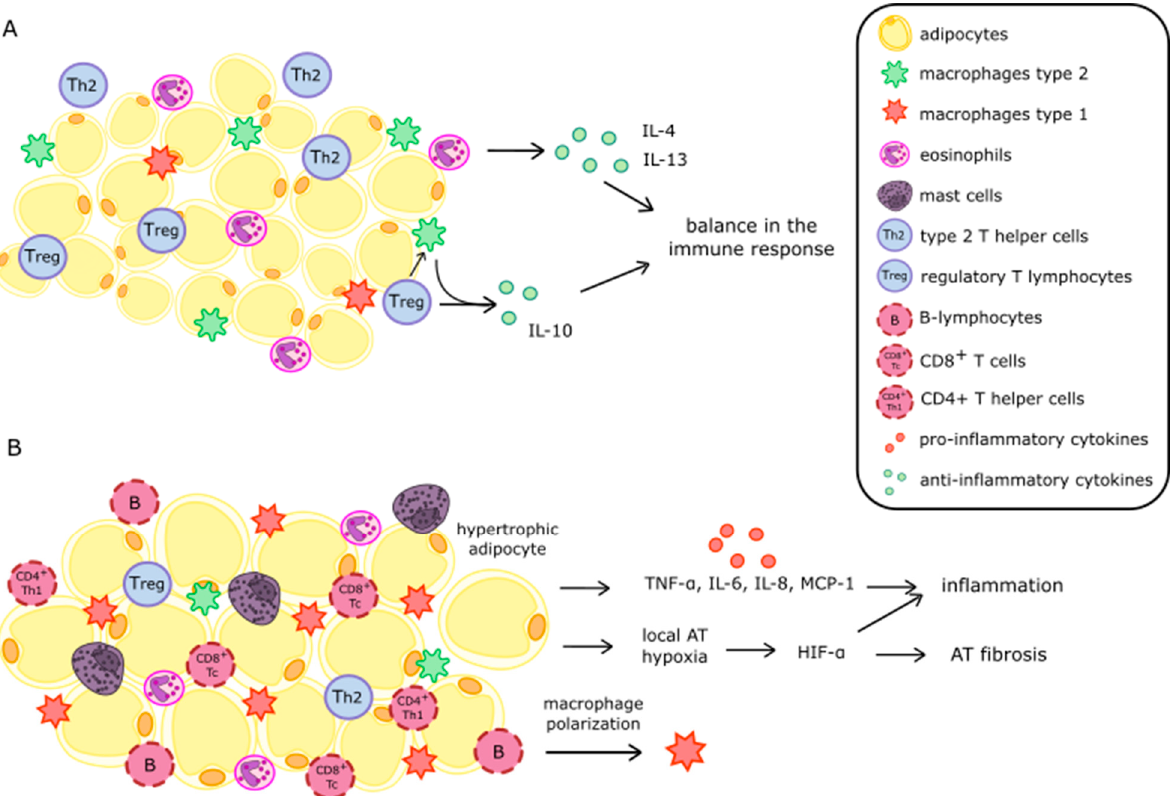
Figure 1. Comparison of adipose tissue of humans with normal body weight ( A ) and with obesity ( B ). Abbreviations: AT—adipose tissue; IL-4,-6,-8,-10,-13—interleukin -4,-6,-8,-10,-13; TNF- α —tumor necrosis factor α ; MCP-1—monocyte chemoattractant protein-1; HIF- α —hypoxia-inducible factor α